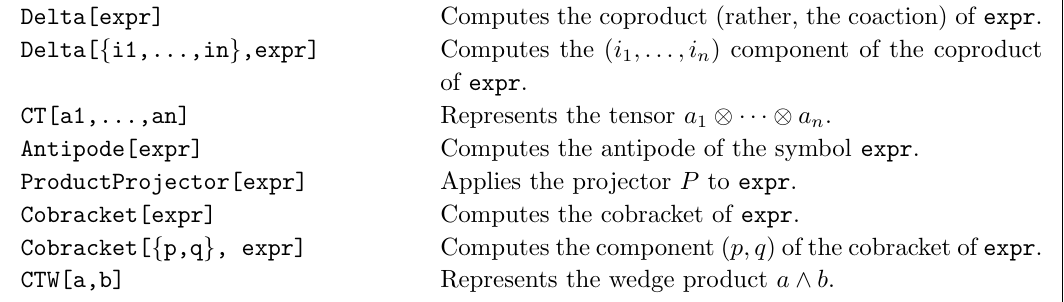
Table 3 . The Hopf algebra of